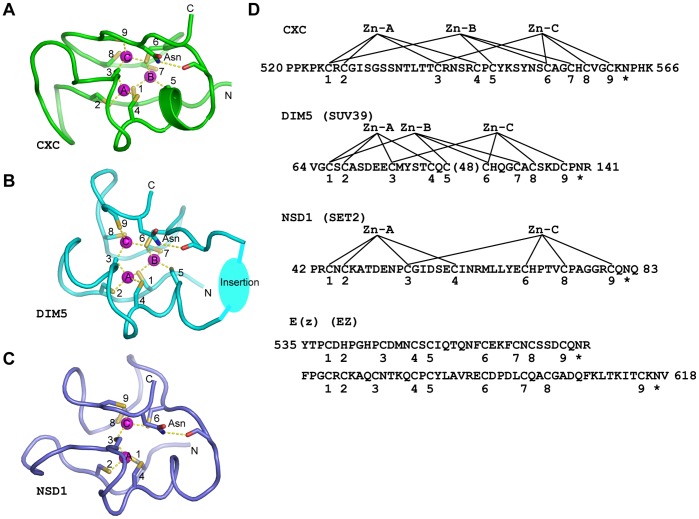
Structural similarity between CXC and pre-SET domains.(A) Structure of MSL2 CXC domain. The Cys ligands and the C-terminal invariant Asn residue are shown as sticks, zinc ions as purple spheres and Zn-S coordination bonds and hydrogen bonds as dotted lines. (B) Structure of the SUV39 family Dim5 pre-SET domain (PDB code 1ML9). The long insertion between Cys-5 and Cys-6 is shown schematically as an oval. (C) Structure of the SET2 family NSD1 pre-SET domain (PDB code 3OOI). The three structures of MSL2 CXC, Dim5 pre-SET and NSD1 pre-SET domains are aligned by their Zn-Cys clusters. (D) The primary sequences of MSL2 CXC domain and pre-SET motifs of Neurospora crassa Dim5, human NSD1 and Drosophila melanogaster E(z). The observed or predicted zinc ligands are numbered sequentially from 1 to 9. The invariant C-terminal Asn is marked with asterisk. The coordination patterns of zinc ions observed in these structures are shown. The starting and ending residues of each sequence are labeled with residue numbers. A 48-residue region is omitted in DIM5 pre-SET. The zinc ligands in NSD1 pre-SET are numbered according to those in the CXC domain.